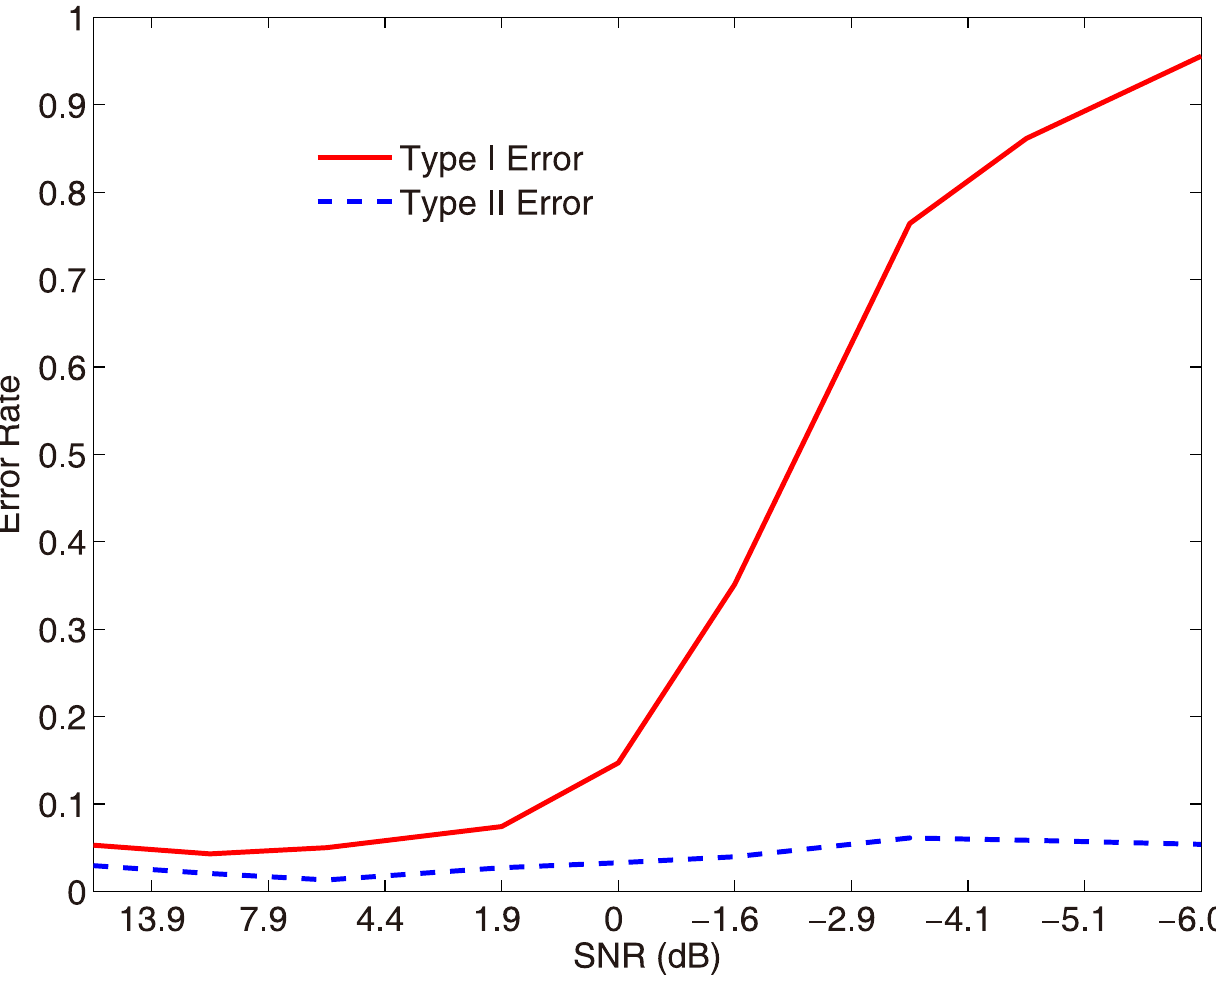
Figure 4. Performance of the proposed approach at different signal-noise-ratios (SNRs). SNR is systematically varied by changing the variance of the white noise superimposed in the trivariate data. At each SNR level, a data set of 100 trials is generated. The proposed method is applied to each trial to measure the signal identification performance, as quantified by both Type I error and Type II error. doi:10.1371/journal.pone.0099793.g004 Table 2. Statistical identification of significant IMFs by the proposed method when the pink noise (1/f) in the data is different from the white noise in the reference